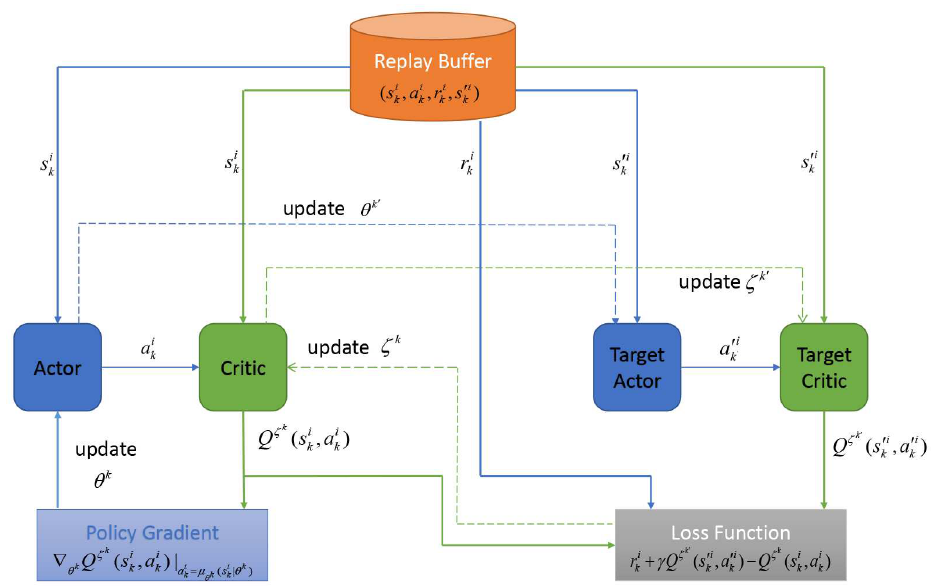
Figure 2. Flow chart of the DDPG algorithm.